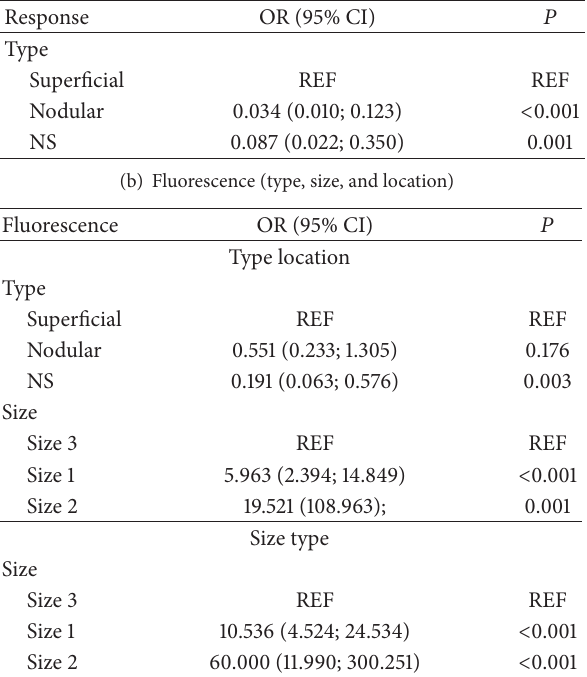
Table 4: Interaction between response and fluorescence and the remaining variables